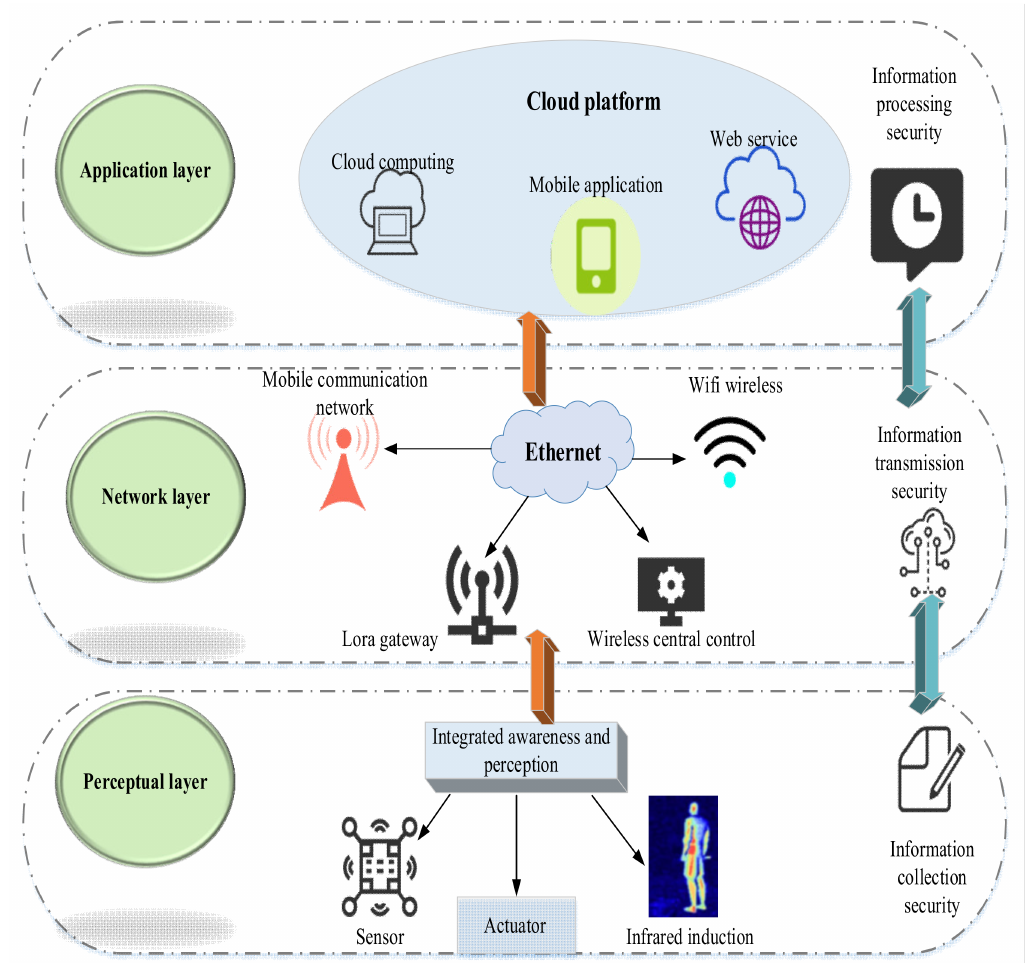
Figure 5. IoT+cloud platform